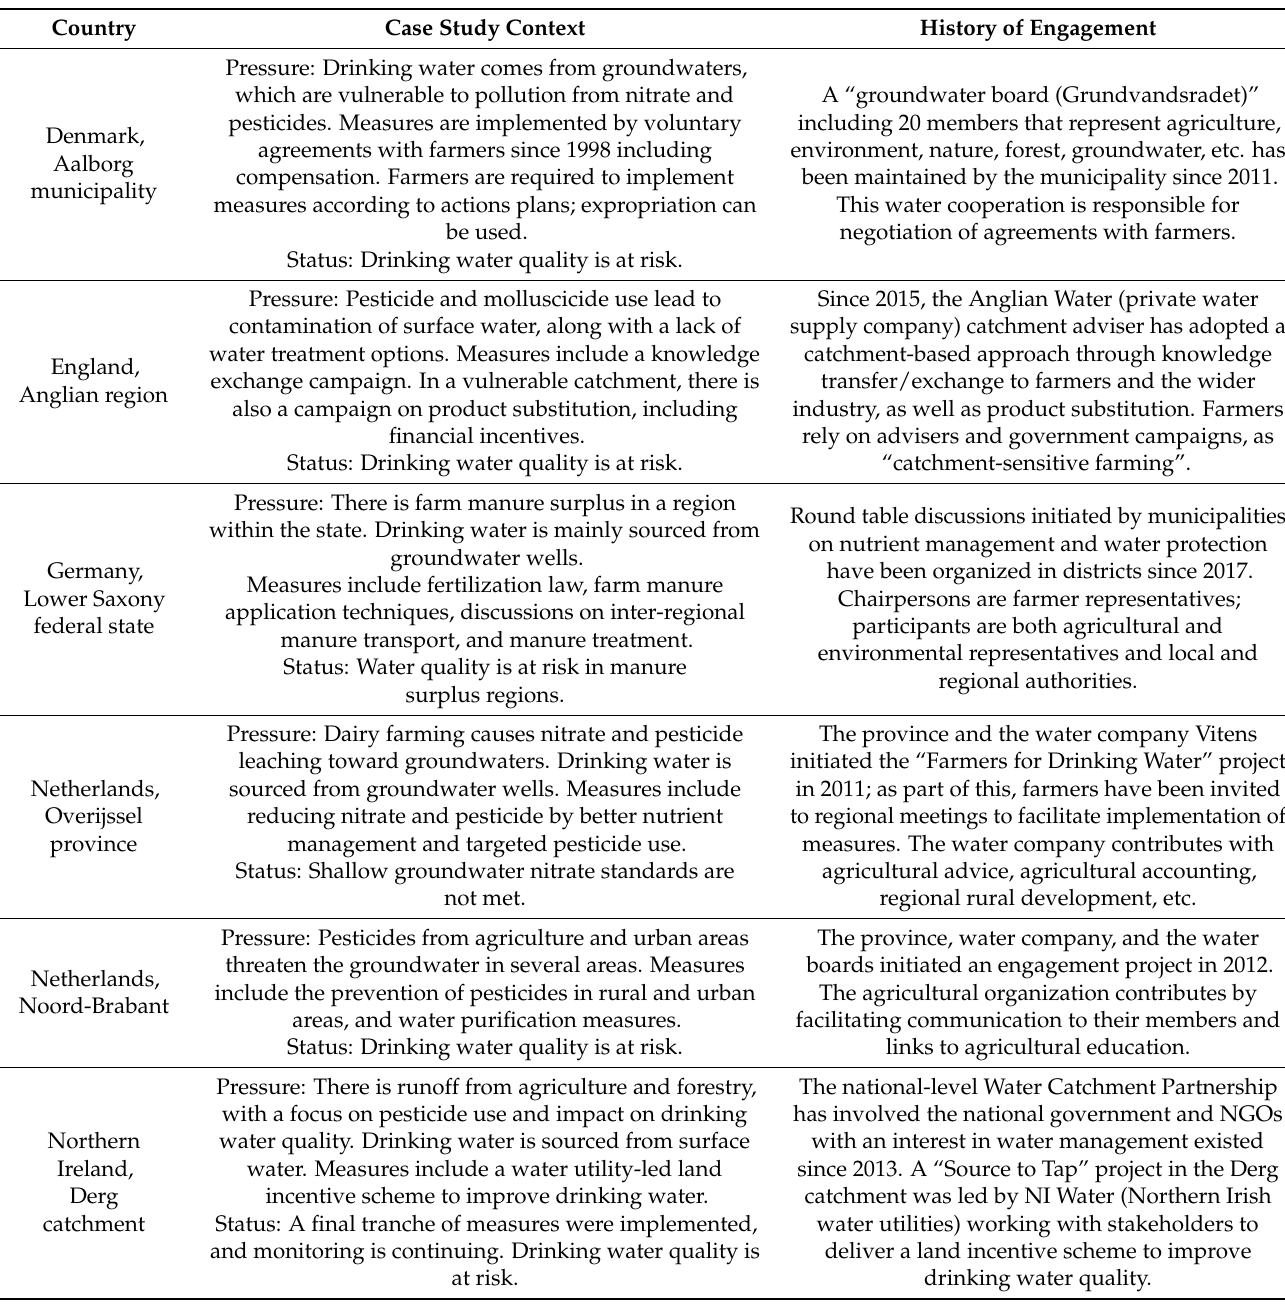
Table 1. Case area